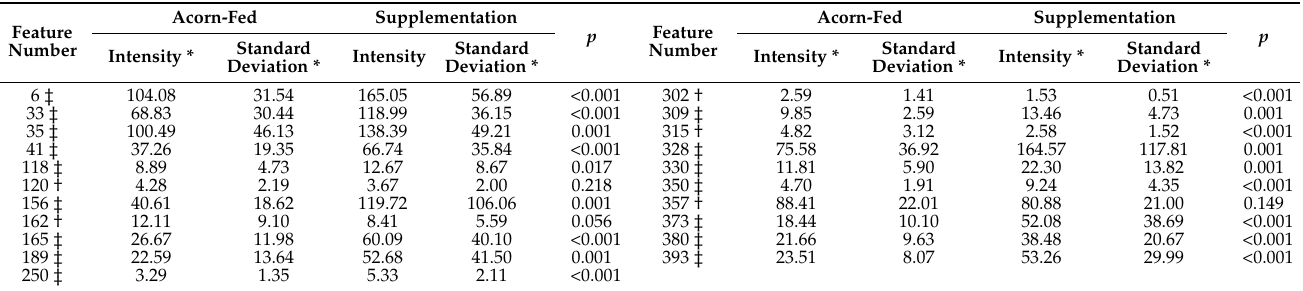
Table 4. Results obtained for the Student t test performed with the 21 final features of PLS-DA model (targeted